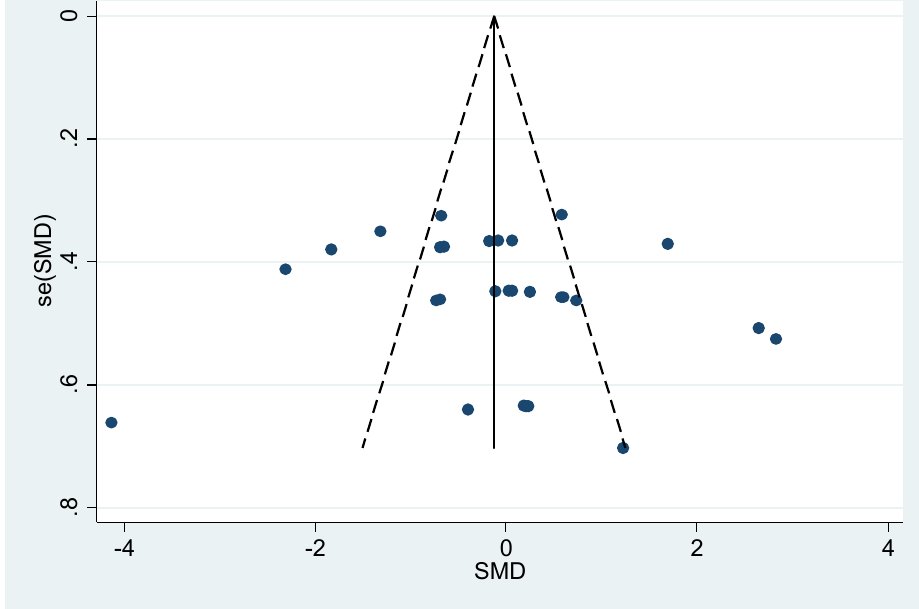
Figure 2. Forest plot showing standardised mean difference (SMD) comparing the overall marginal fit of crowns by CAD/CAM with controls included studies investigating the marginal fit of crowns using an intra-oral or laboratory scanners. [Ng et al., 2014; Neves et al., 2014; Anadioti et al., 2014; Abdel-Azim et al., 2015; Kim et al., 2016; Alqahtani 2017; Zeltner et al; 2017; Azar et al., 2018; Mostafa et al; 2018; Elrashid et al; 2019; Al Hamad et al; 2019; Lee et al; 2020]. Figure 3 suggests that there is no evidence of publication bias but clearly displays over-dispersion caused by the heterogeneity.